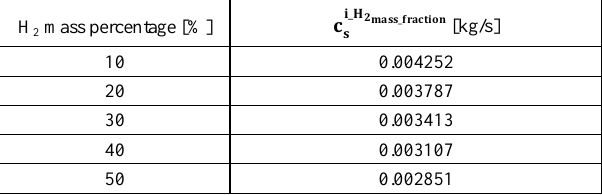
Table 4. Fuel mass flows as function of hydrogen mass percentage in fuel